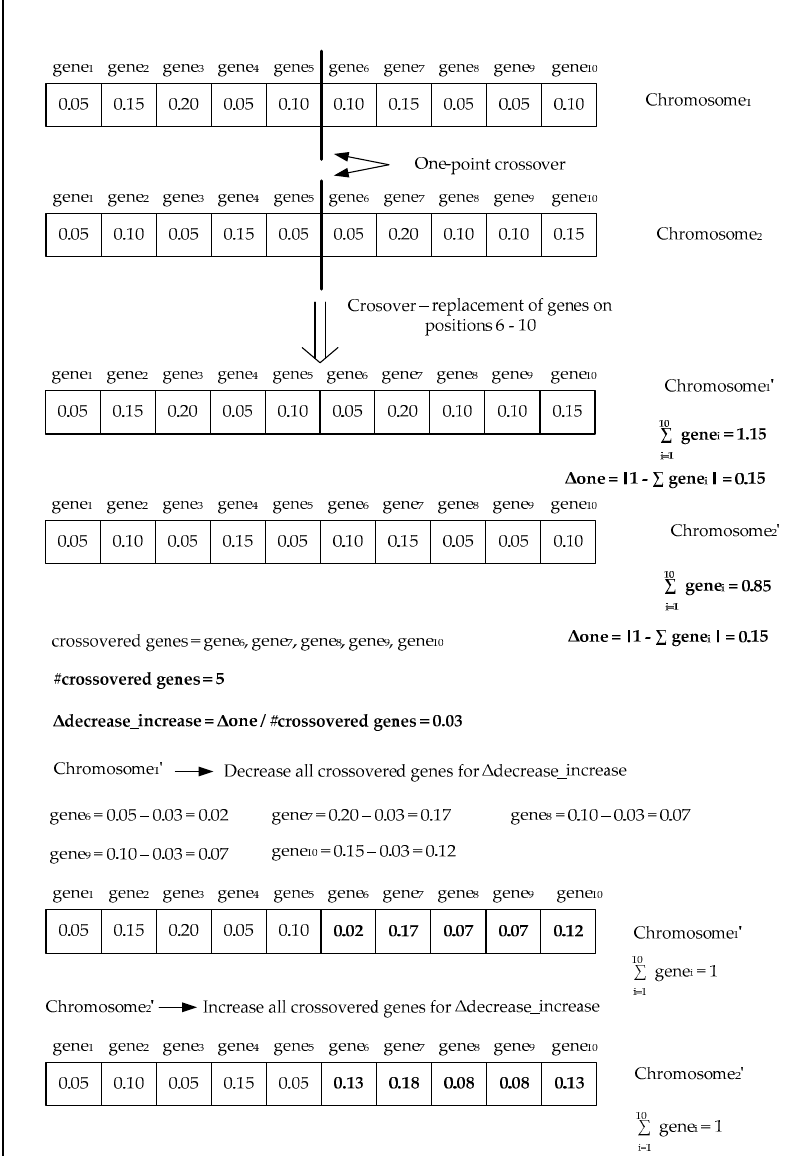
Figure 7. One-point crossover with increased/decreased values of crossovered genes.